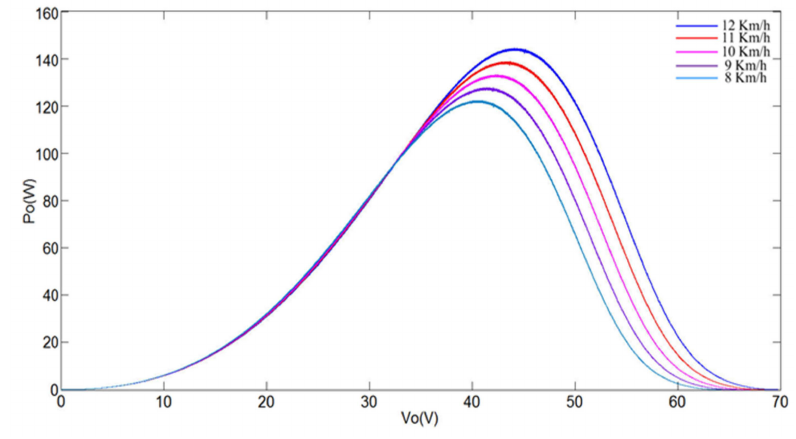
Figure 7. GBEE characteristic curves under different